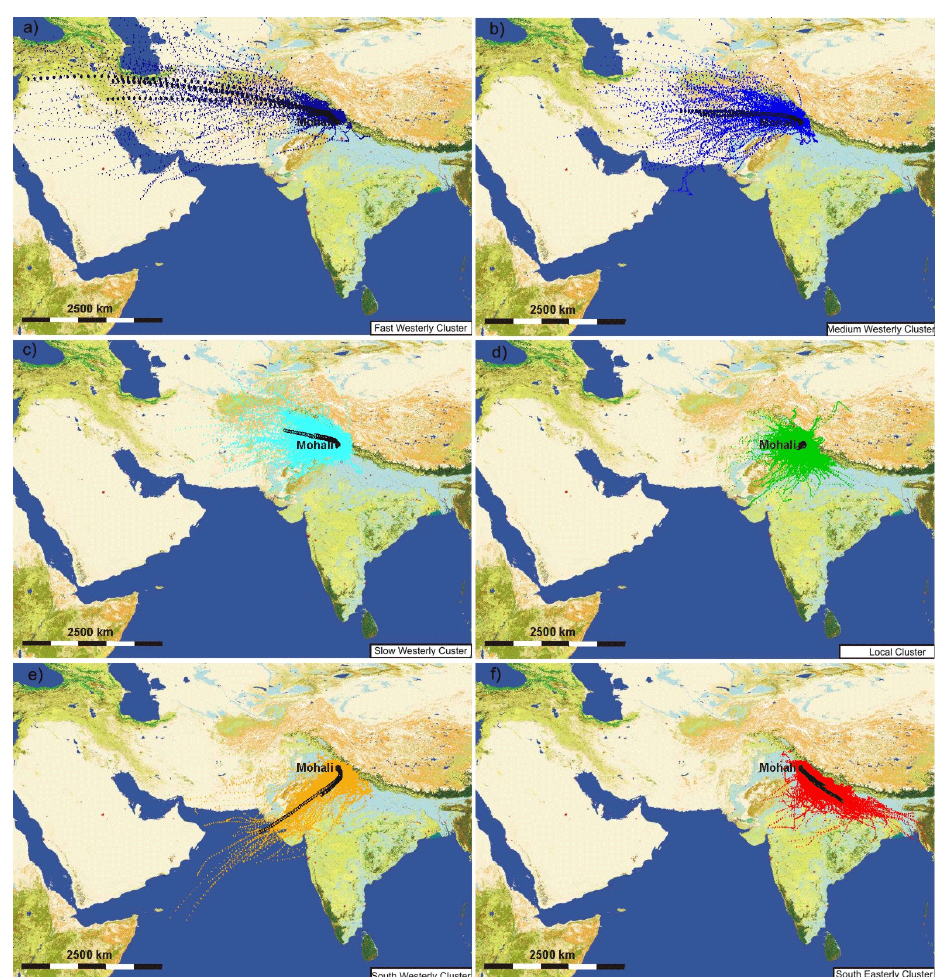
Figure 4. (a – f) All individual trajectories that contributed to each of the clusters and the cluster mean, superimposed on a land classification map (courtesy of the ESA GlobCover 2009 project). The length of each mean trajectory is 3 days and the distance between two successive data points represents a 1h interval. The average trajectory of each cluster has been superimposed using circles with a black